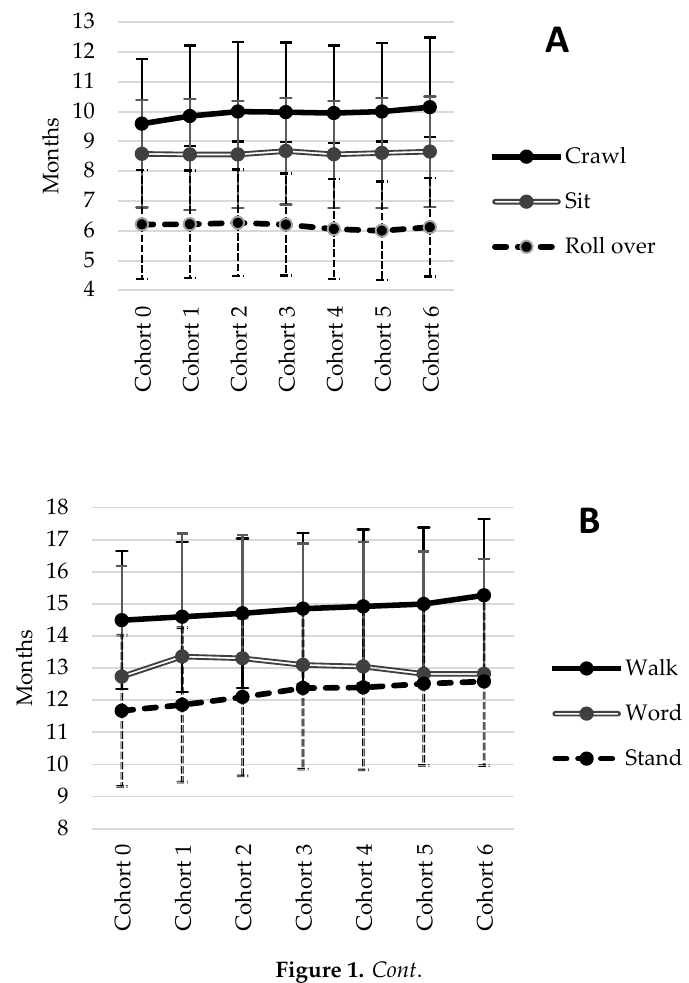
Table 2. Baseline descriptive statistics of twins from the Young Netherlands Twin Register